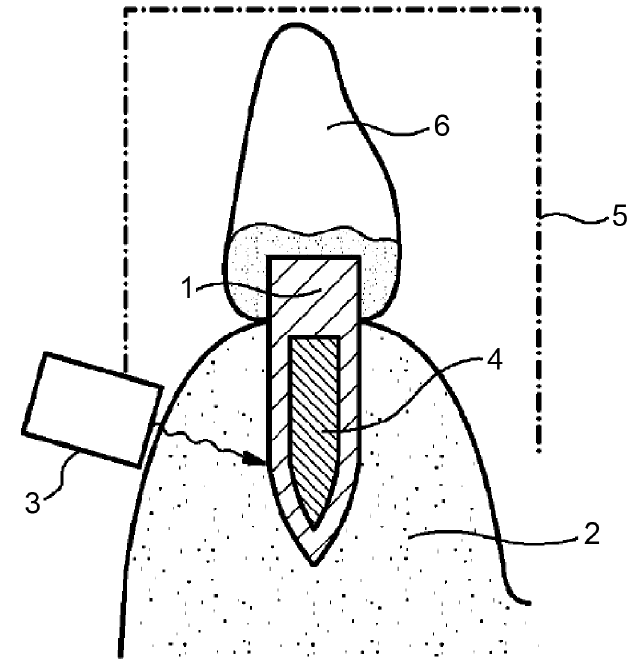
Figure 4. An induction source (3) can be placed on the alveolar bone (2) adjacent to the implant (1). Ferromagnetic material (4) is embedded within the implant. The implant is heated by eddy current losses, working primarily within the ferromagnetic material. Source: [49].